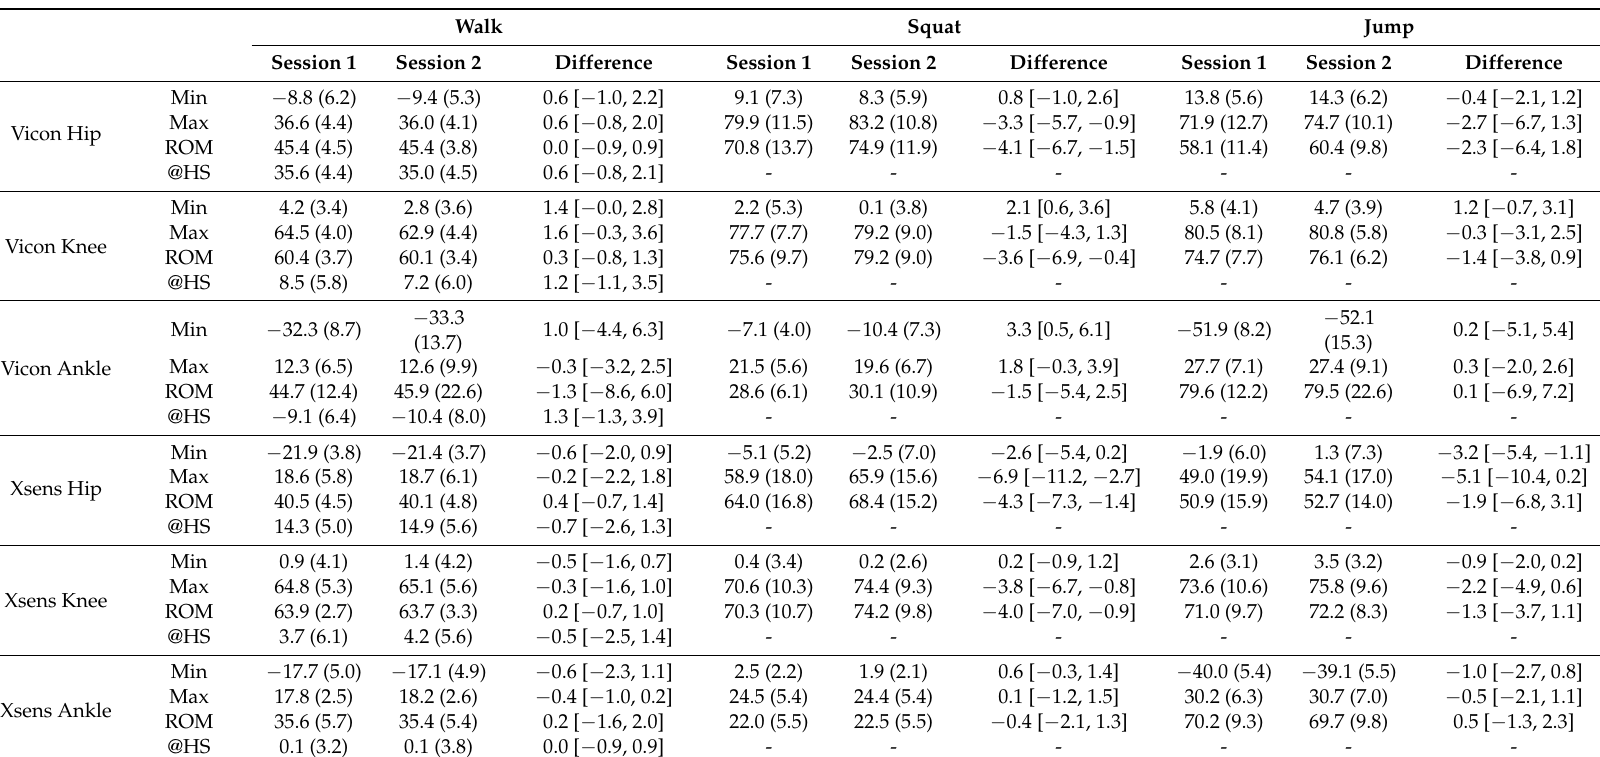
Table A1. Within-rater (between-session) reliability of sagittal plane kinematic parameters (left side of the body). Data for each session are mean (standard deviation). Data for the difference are difference [95% confidence